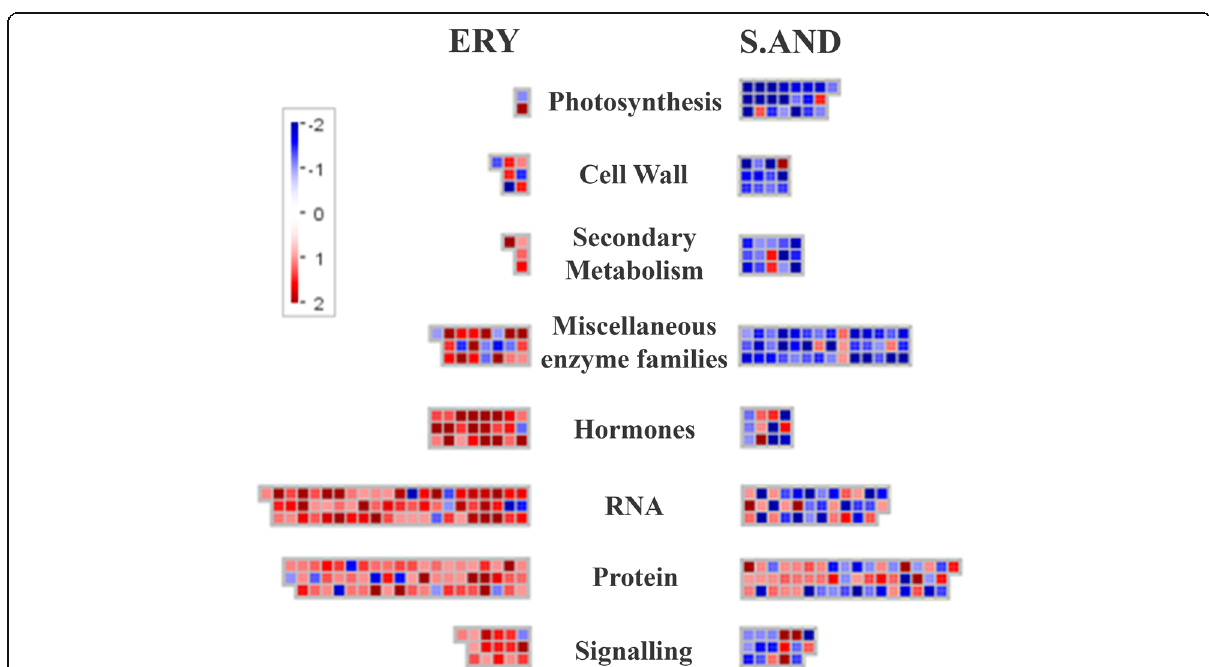
Fig. 4 Overview of different pathways specifically deregulated in cold stress anthers. Specific up- and downregulated genes (red and blue, respectively) in cold-stress post-meiotic anthers from ERY and S.AND cultivars were analysed by Mapman software (Thimm et al. 2004)